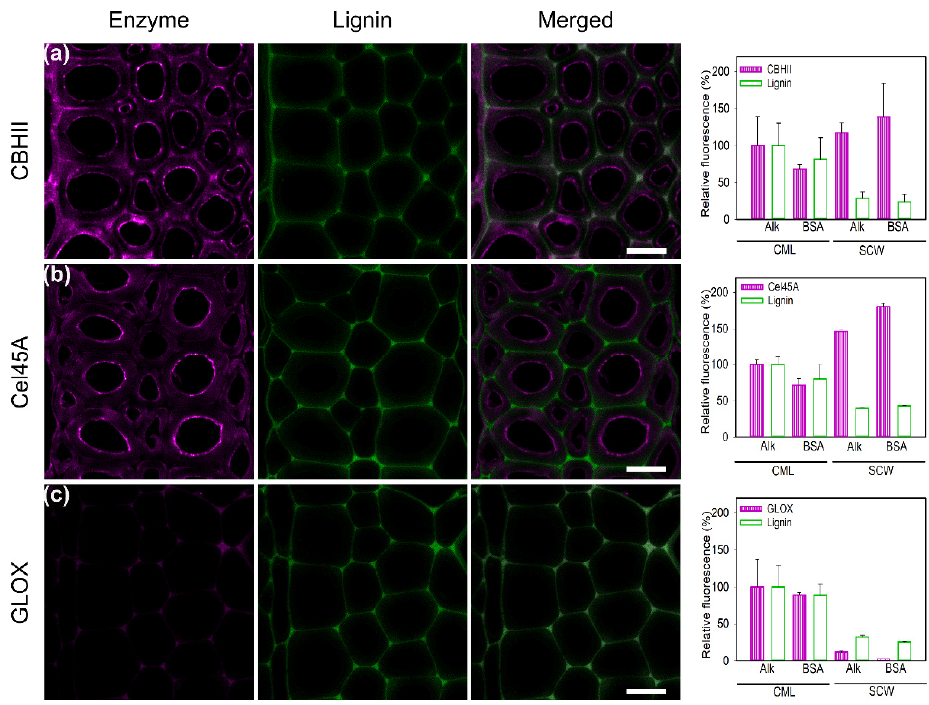
Figure 5. CLSM images of conjugated ( a ) CBHII, ( b ) Cel45A, and ( c ) GLOX on delignified poplar samples after incubation with 1% BSA. Enzyme fluorescence is colored in magenta. Lignin autofluorescence is shown in green. The merged column displays the overlay of enzyme and autofluorescence channels. Histograms show the maximum relative fluorescence intensity, expressed in percentage, of the alkali-treated compound middle lamella (CML), designated as 100%, and its comparison after 1% BSA preincubation. Scale bars correspond to 10 µ